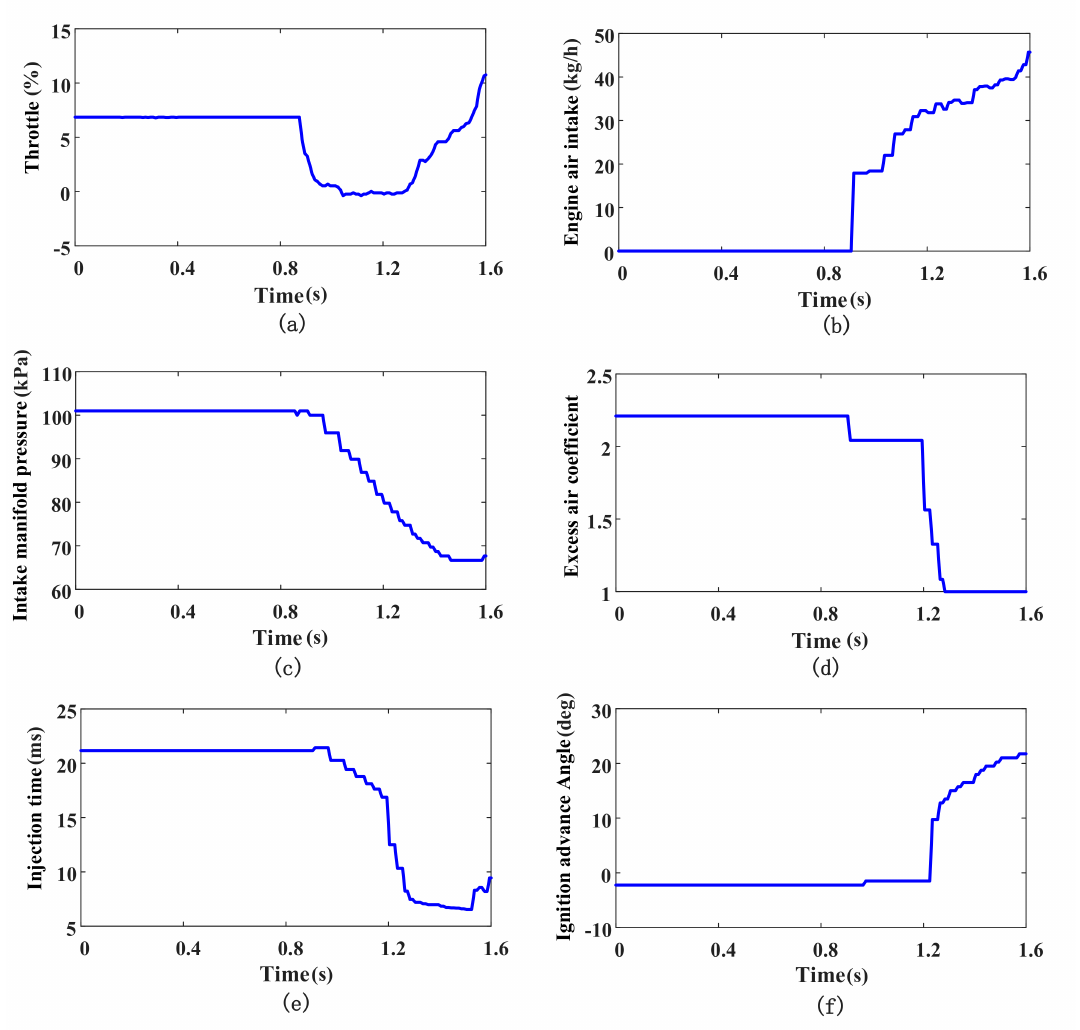
Figure 6. Engine control unit (ECU) variable values: ( a ) throttle; ( b ) engine air intake; ( c ) intake manifold pressure; ( d ) excess air coefficient; ( e ) injection time; ( f ) ignition advance angle.